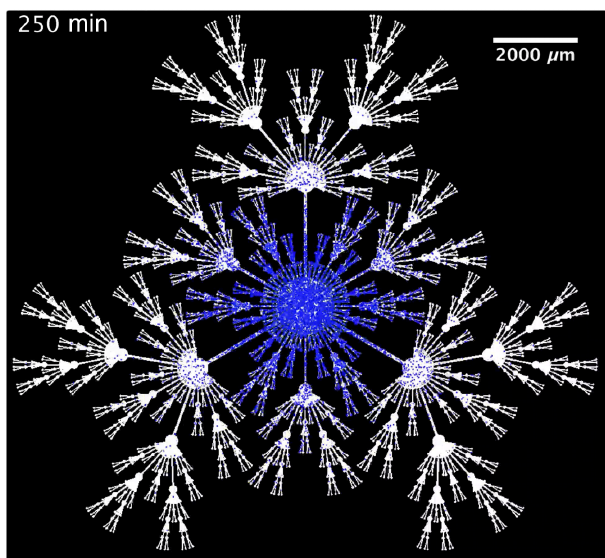
FIG. 10. Simulation of nonchemotactic bacterial 250 min after